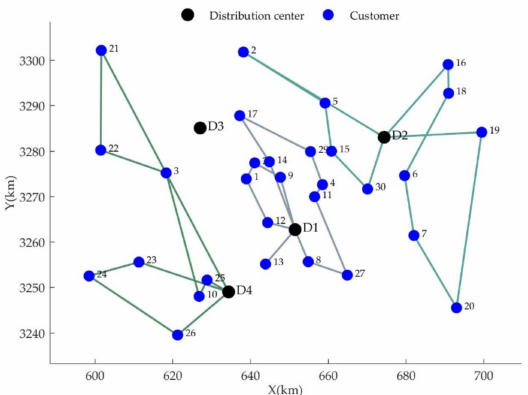
Figure 5. Location-routing scheme that does not consider cargo splitting.